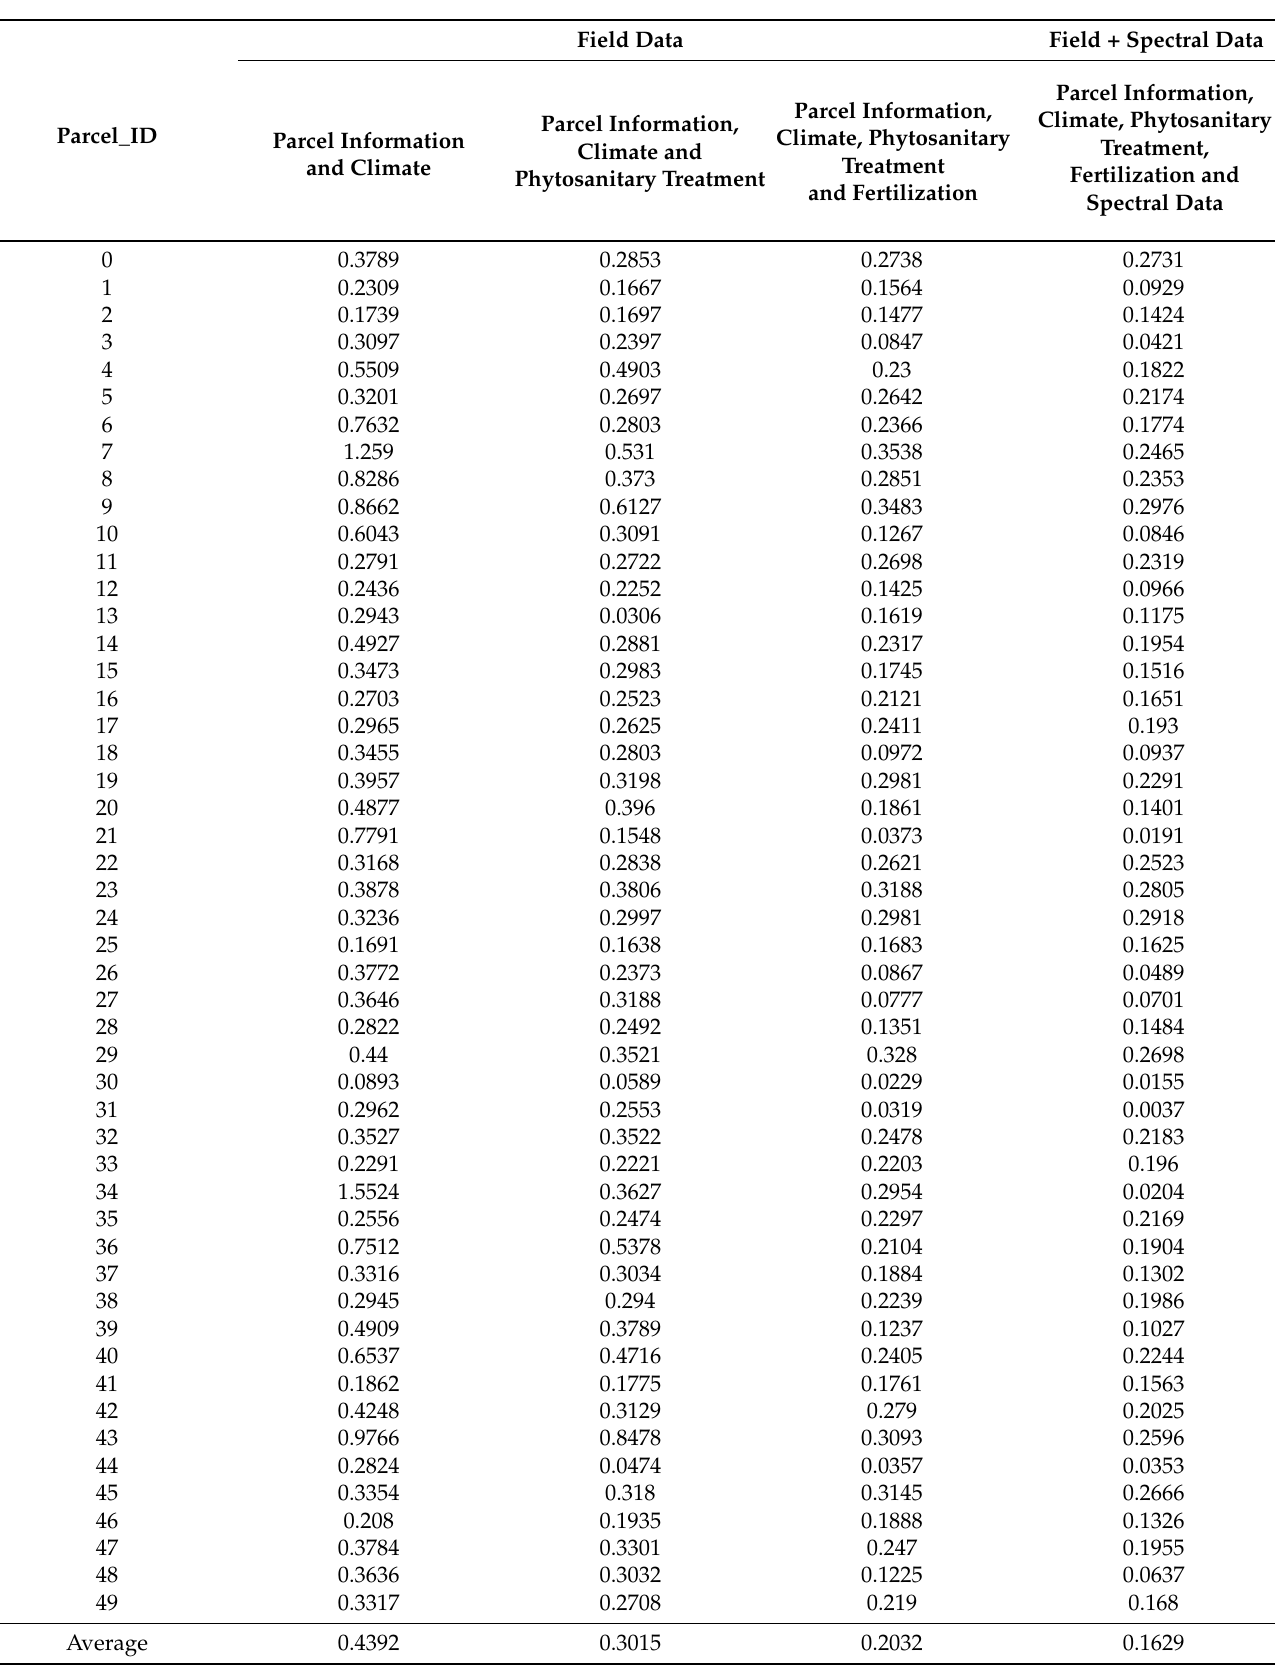
Table 4. Yield prediction percentage error per